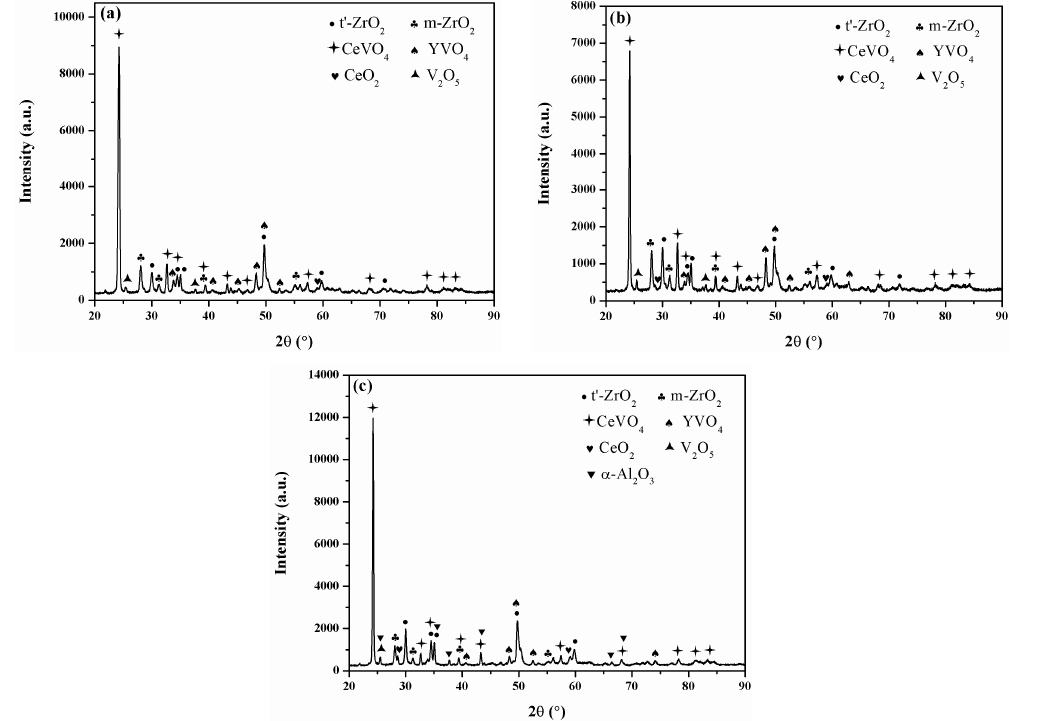
Figure 16. The XRD patterns of ( a ) plasma-sprayed, ( b ) dotted, and ( c ) DA coatings after the hot corrosion test at the 2 θ range of 20°–90°.